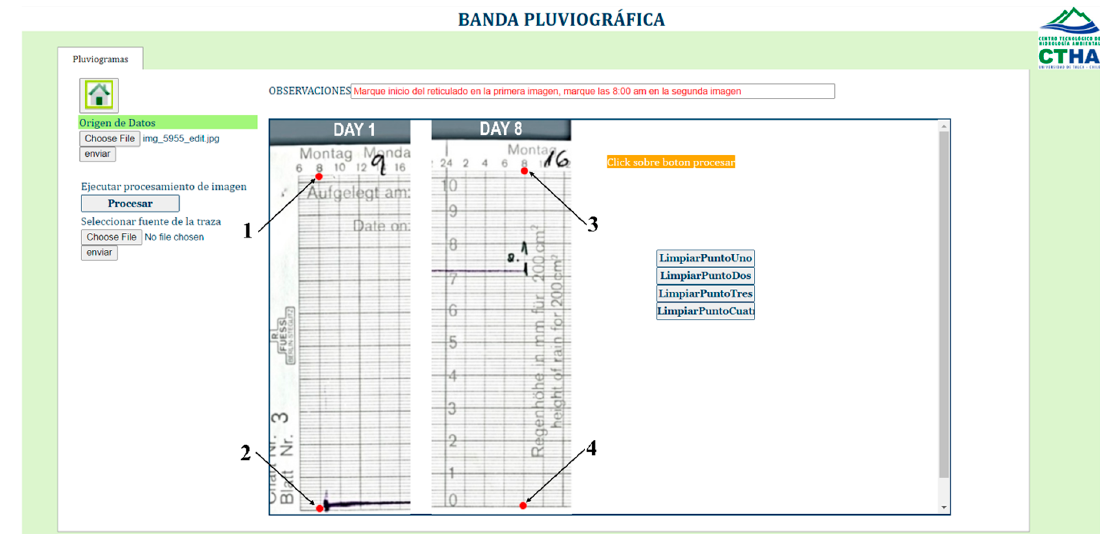
Figure 6. Control points for selecting the target region or area of interest (AOI).